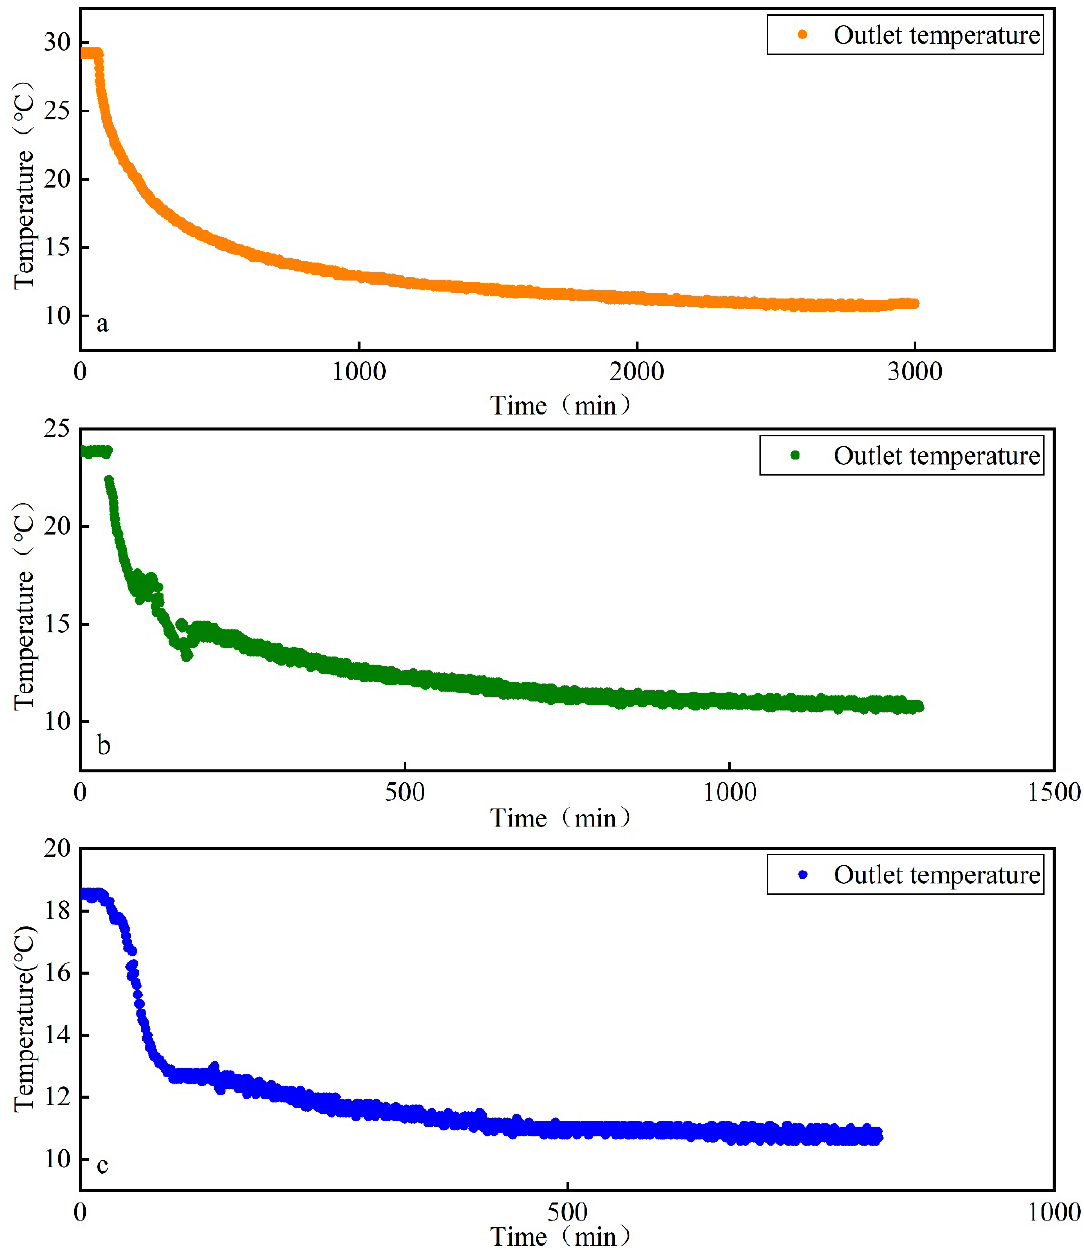
Figure 9. Outlet temperature after stopping heating. ( a ) Condition R1. ( b ) Condition R2. ( c ) Condition R3.